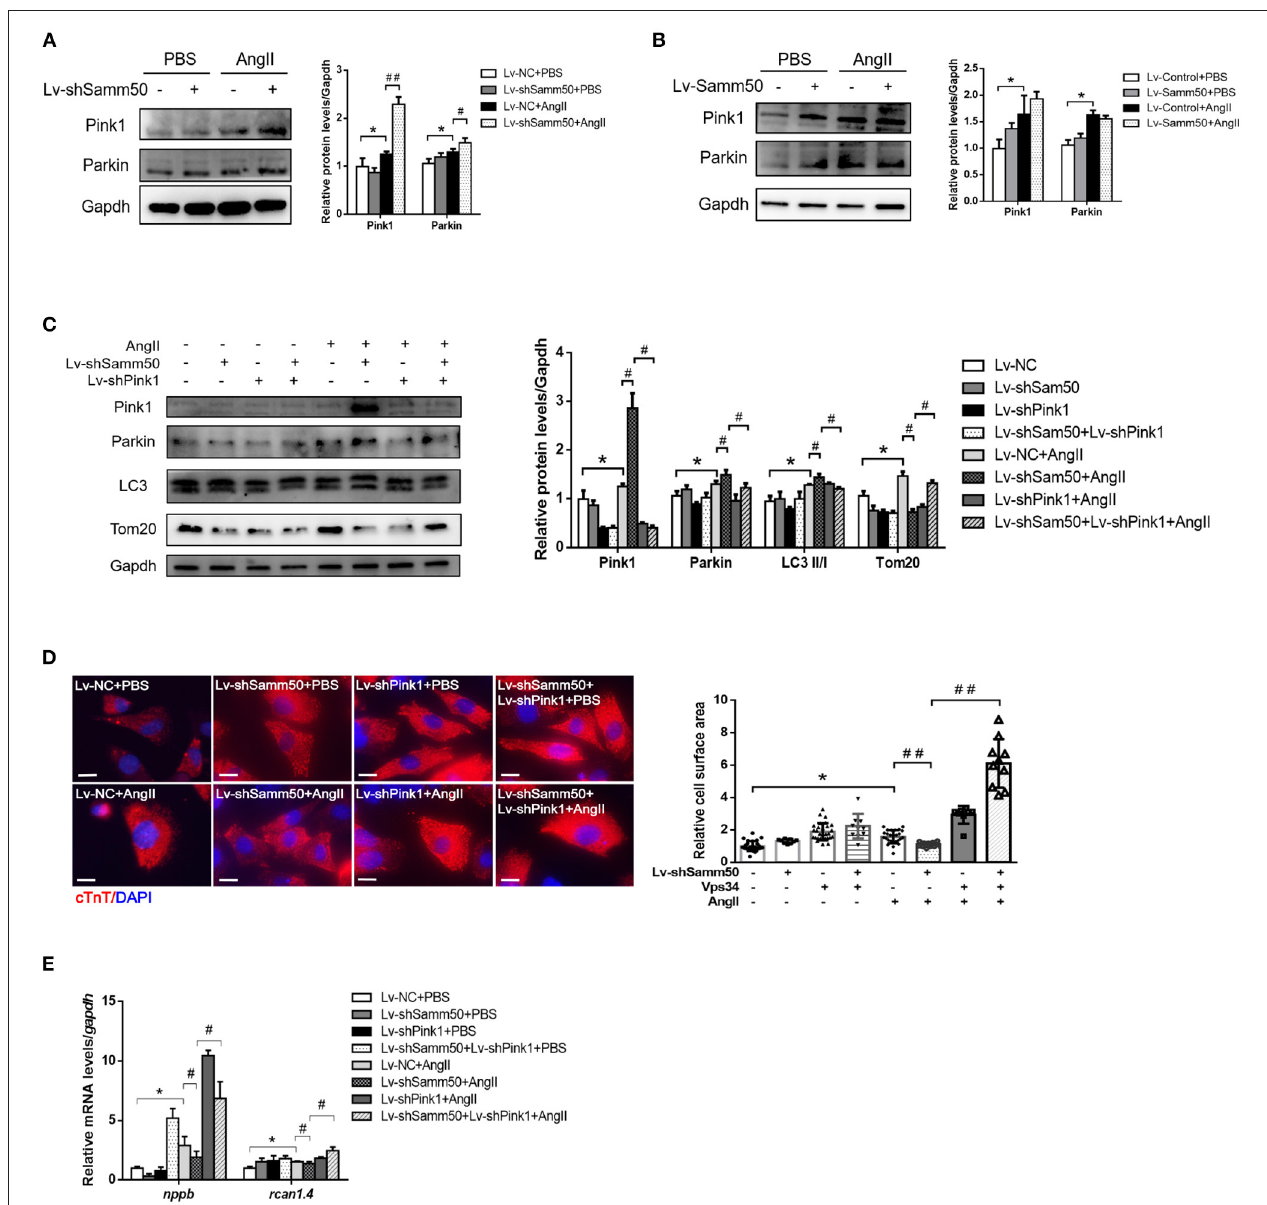
FIGURE 4 | Samm50 regulates Pink1-Parkin-mediated cardiomyocyte mitophagy. (A) Cardiomyocytes transduced with Lv-NC or Lv-shSamm50 lentivirus were treated with Ang II and subjected to immunoblot analysis. (B) WB analysis of indicated proteins in Lv-control or Lv-Samm50 cardiomyocytes in response to Ang II. (C) Immunoblotting analysis for indicated proteins of control and Samm50-deficient cardiomyocytes infected with control or shPink1 lentiviral particles (D,E) Cell surface area and quantification of hypertrophic markers expression in cardiomyocytes infected with indicated lentivirus with Ang II stimulation. Scale bars, 10 µ m. * P < 0.05 compared with the control group; # P < 0.05 compared with Ang II group; ## P < 0.01 compared with Ang II group. All data are presented as mean ± s.e.m.